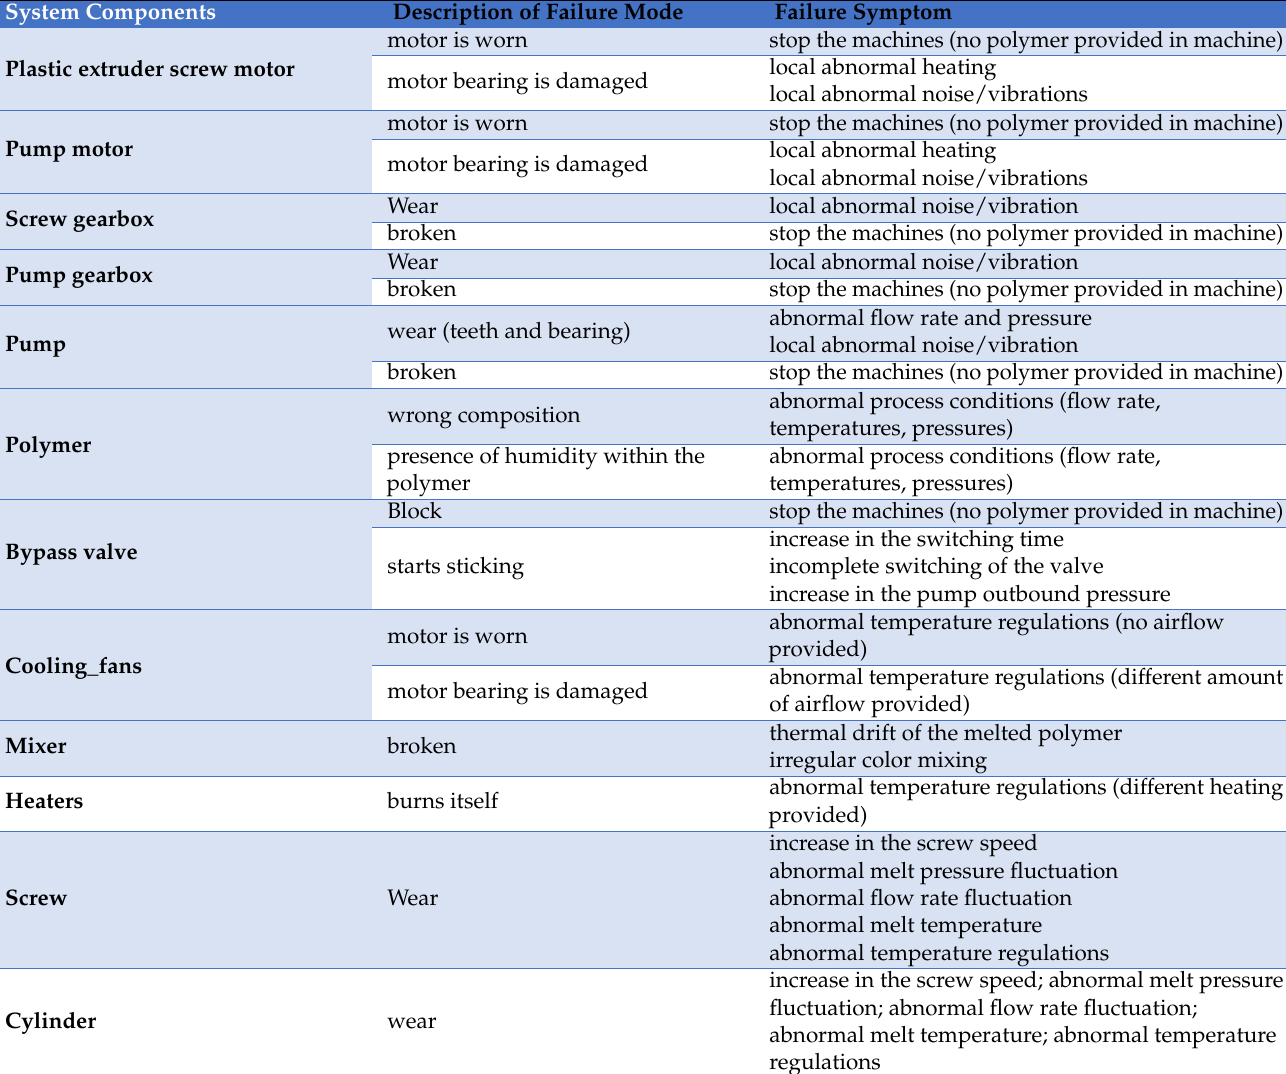
Table A2. System Components, Failure Modes, Failure Symptoms.